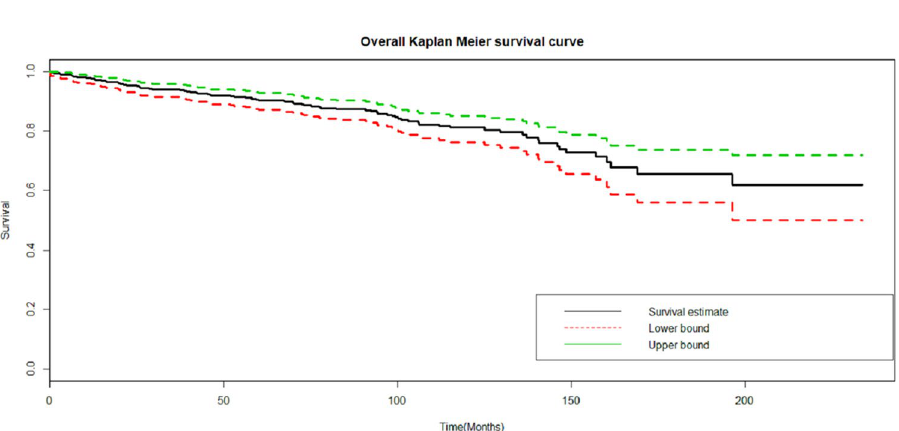
Figure 2. The plot of the overall estimate of Kaplan–Meier survivors for time to DR among T2DM patients under anti-diabetes treatment at UGCSH, 2001–2016. The black line indicates the survival estimate, and the red and green line show the lower and upper boundaries of the estimate. The median survival time or the survival time at which the cumulative survival function was equal to 0.5 could not be